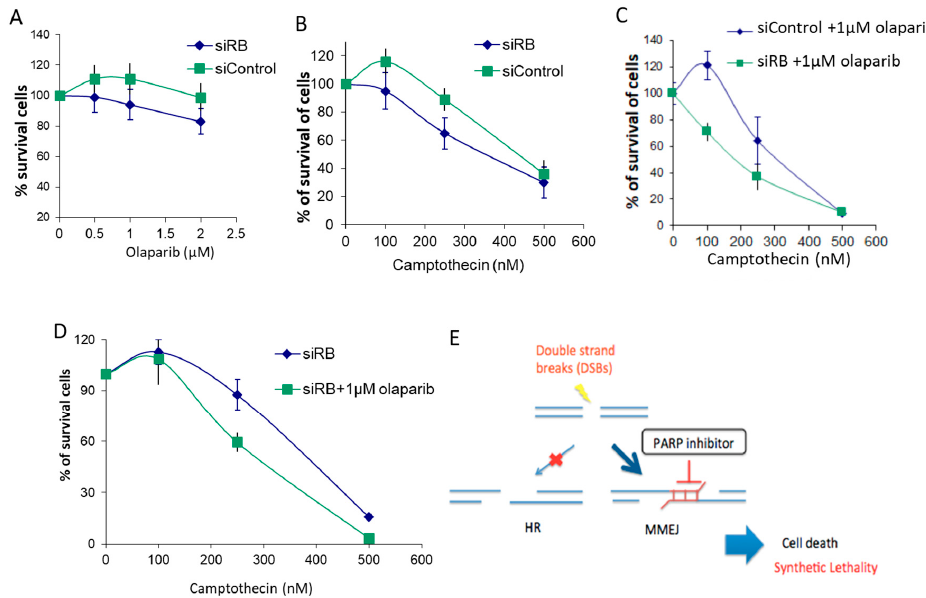
Figure 4. RB knocked-down cells were hypersensitive to the combined treatment of poly-ADP ribose polymerase 1 (PARP1) inhibitor and camptothecin. ( A ): Cell survival was quantified by MTT assay in RB knocked-down cells with different dosages of olaparib for 3 days. ( B ): Cell survival was quantified by MTT assay in RB knocked-down and control cells treated with different dosages of CPT for 3 days. ( C ): Cell survival was quantified by MTT assay in RB knocked-down and control cells treated with different dosages of CPT with 1 μ M olaparib for 3 days. ( D ): Cell survival was